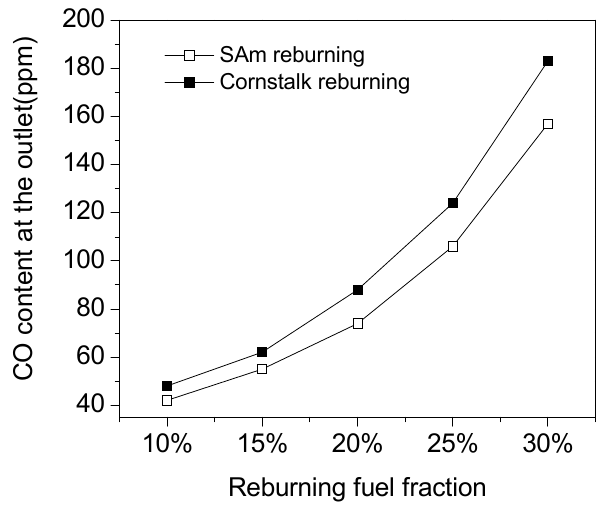
Figure 9. CO content at the outlet under different R ff .